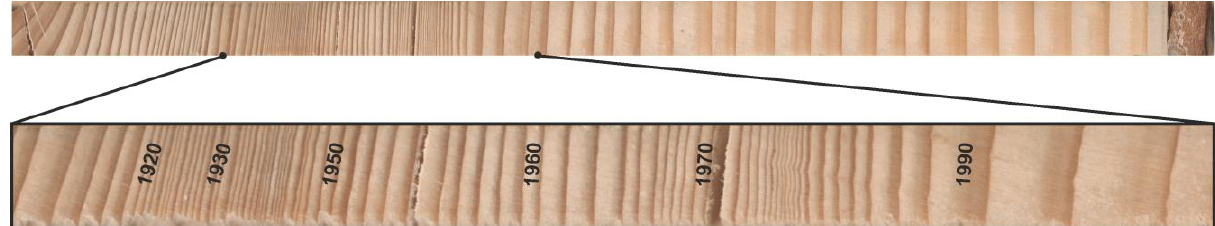
Fig. 2. Part of the core collected from the stem of a fir growing on the study site. Periods when tree rings were relatively wide (e.g. after 1987) as well as reduced tree rings (e.g. in the 1920s, 1930s, 1940s and 1980s) are